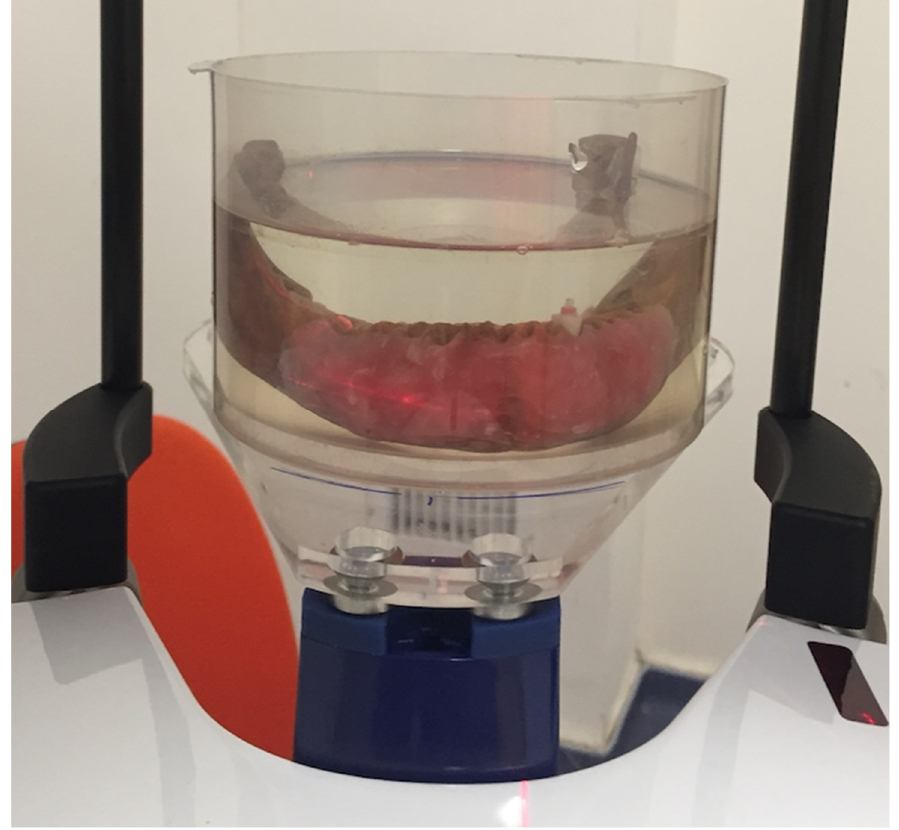
Figure 1. Mandible placed in a round plastic box with wax covering the alveolar crest. The CBCT images were taken using a Planmeca CBCT machine (Planmeca ProMax 3D Max) with the following parameters: two different kVps (90 kVp and 96 kVp), three different metal artifact reduction (MAR) algorithms (no MAR, medium MAR, and high MAR), and two different resolutions (100 voxels and 200